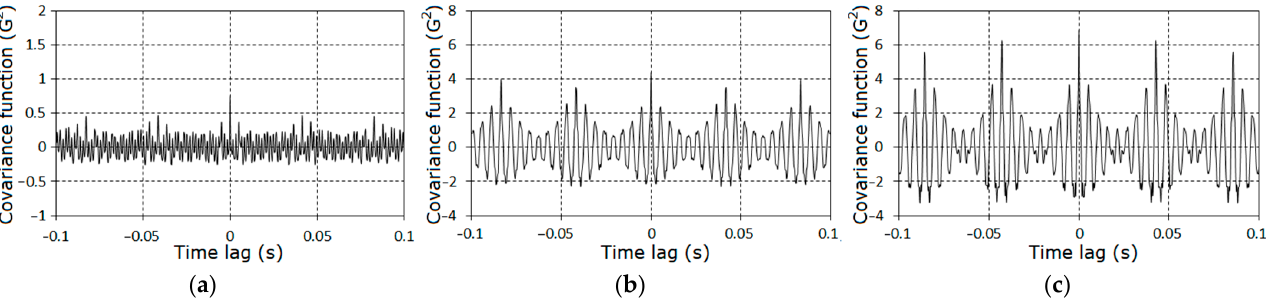
Figure 4. The covariance function estimators for the filtered signals corresponding to the first ( a ), second ( b ), and third ( c ) stages of the gear tooth failure.